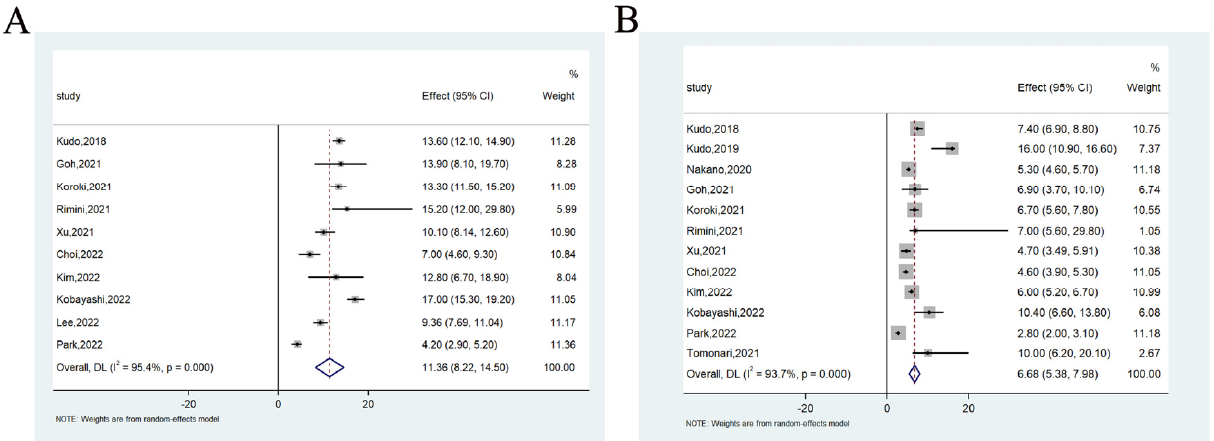
Figure 2. The median OS ( A ) and median PFS ( B ) of lenvatinib in the treatment of unresectable hepatocellular carcinoma.